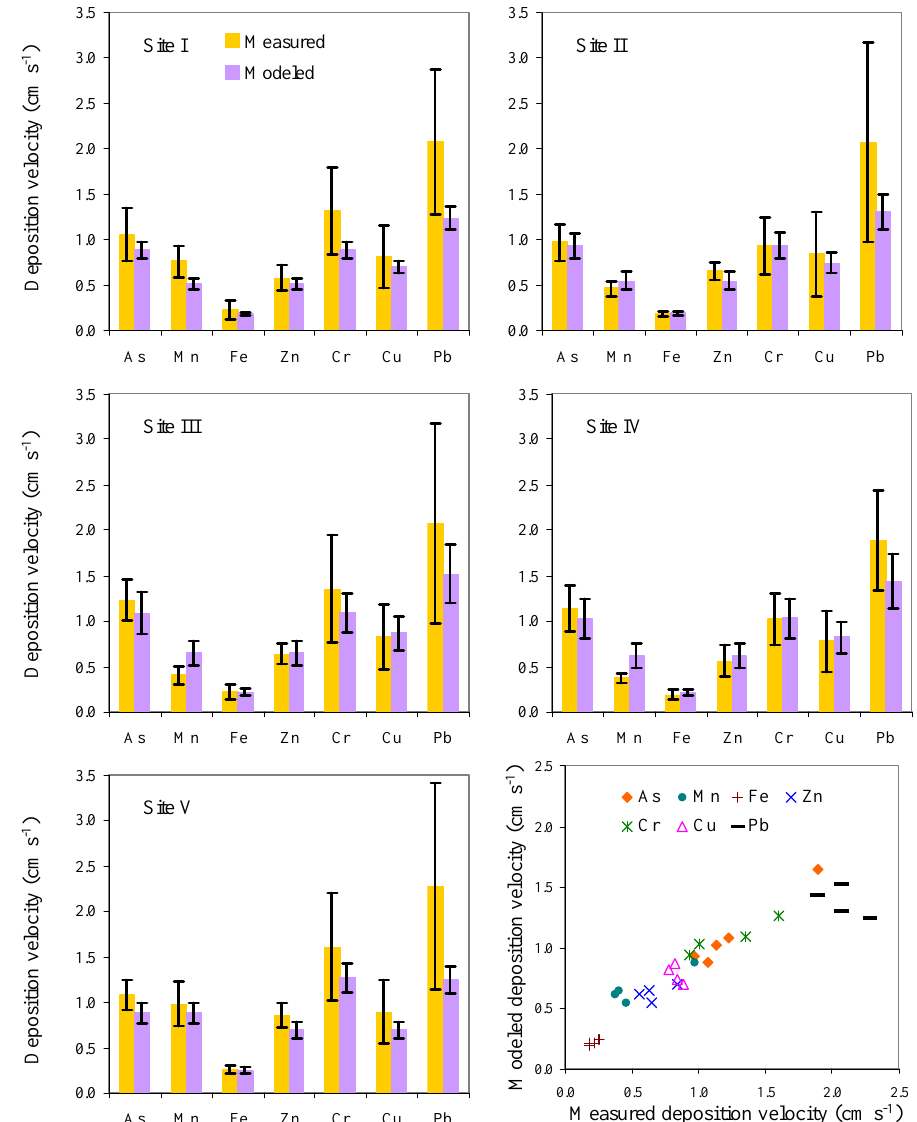
Fig. 4. Annual average of measured and modeled deposition velocities (cms − 1 ) of As, Mn, Fe, Zn, Cr, Cu, and Pb at the five sites and the scatter plot of these